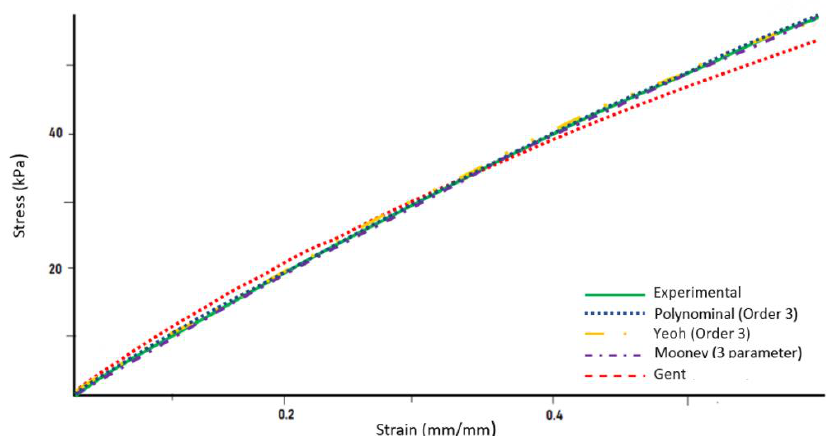
Figure 5. Stress-strain curve solution for different constitutive hyperelastic mathematical models.